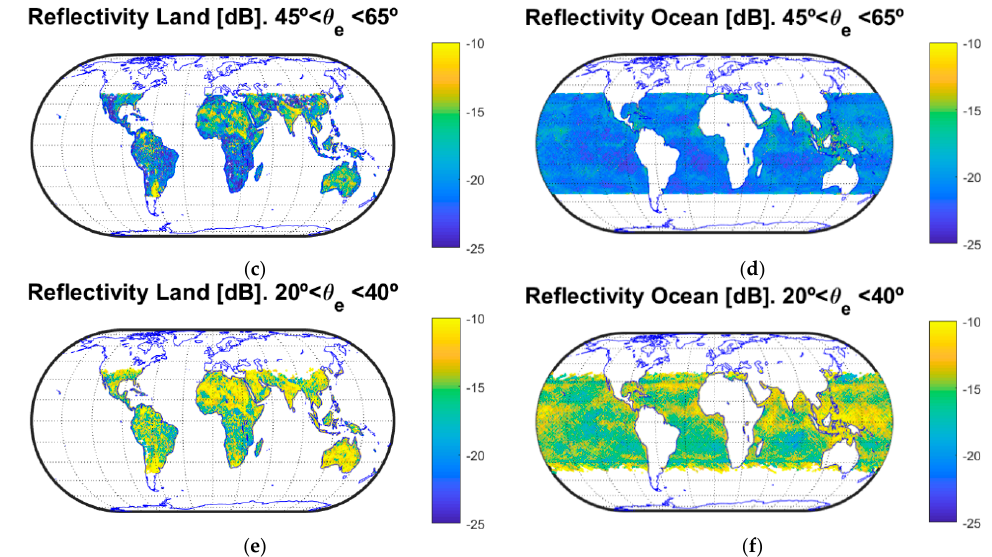
Figure 2. One-month (from 20 September to 20 October 2017) averaged CyGNSS bistatic reflectivity Γ values for elevation angles θ e ≈ [70, 90] ◦ [( a ) land, ( b ) ocean], θ e ≈ [45, 65] ◦ [( c ) land, ( d ) ocean] and θ e ≈ [20, 40] ◦ [( e ) land, ( f ) ocean]. CyGNSS coherent integration time T c = 1 ms, incoherently averaged samples N inc = 1000. Earth’s surface coverage is in the latitude range ≈ [ − 40,40] ◦ because of the orbital inclination ≈ 35 ◦ of the CyGNSS satellites. Thus, only nearly equatorial areas are studied.